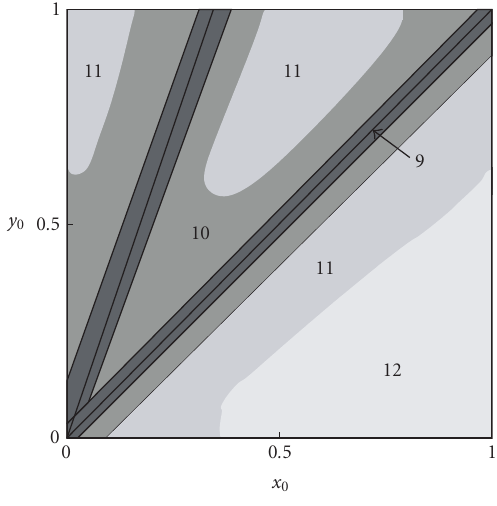
Figure 5.1. Number of iterations with exponential decay.